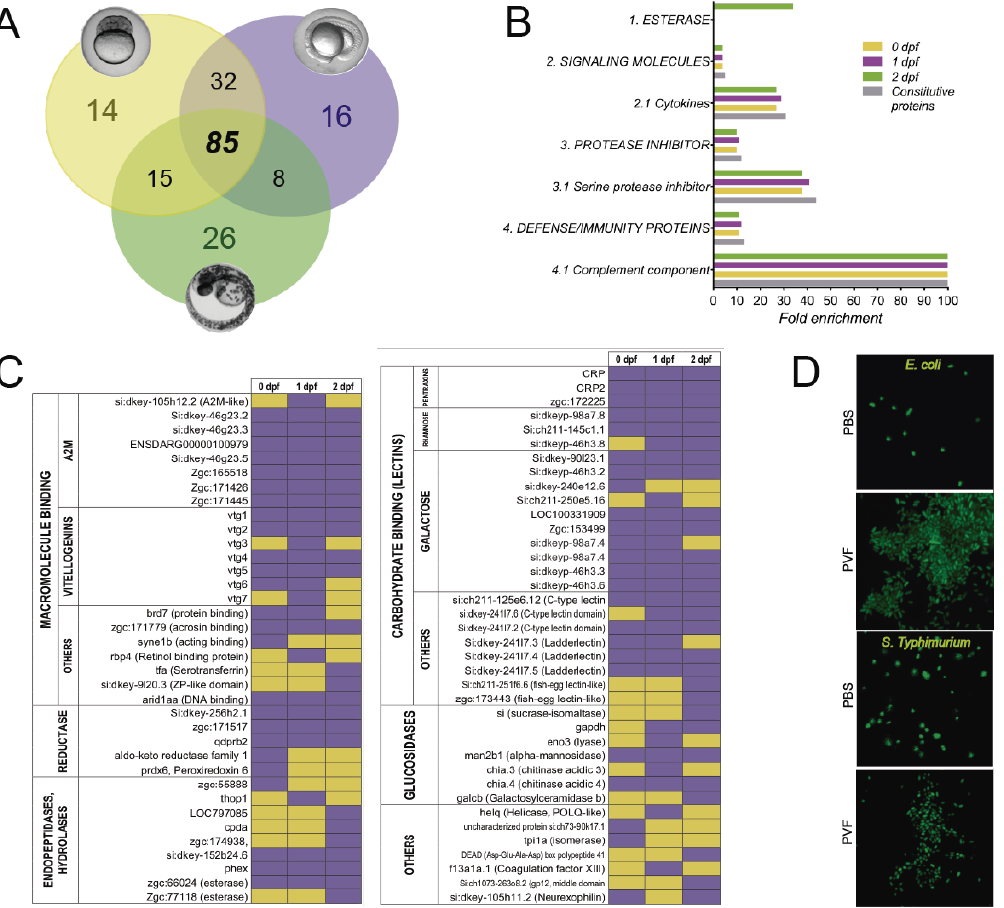
Figure 1. ( A ) The Venn diagram shows the number of exclusive and shared proteins present in the perivitelline fluid (PVF) at different stages: early blastula (yellow), at 1 dpf (purple) and 2 dpf (green). The 85 sequences present at all developmental stages are considered as constitutive of PVF composition. ( B ) Enriched protein classes (according to their Gene Ontology) detected in the PVF. The overrepresentation analysis reveals a marked overrepresentation of protein classes related to immune defense at all stages (Fisher’s test; p < 0.05). ( C ) Identity of proteins (or gene ID) present in the PVF during embryonic development and their presence (purple) or absence (yellow) at different stages. The presence of a protein at 0 dpf suggests a maternal origin, since samples were taken before the MBT; the absence of a protein at this stage suggests a zygotic origin, while the presence before and after MBT, suggests a mixed maternal-zygotic origin. The gene list associated with each protein found in the PVF was organized by their protein superfamilies, families, and/or molecular functions. For